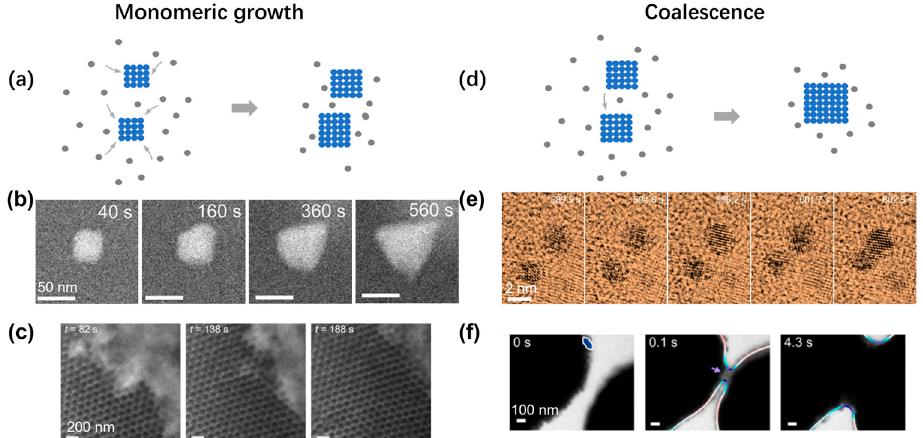
Figure 6. Experimental observations of crystal growth inside liquid-phase TEM: ( a ) Schematic illustrating the growth of crystal via monomeric attachment. ( b ) Time series of liquid-phase TEM showing the gradual growth of an individual nanoparticle. Reproduced with permission from Ref. [73]. Copyright 2021 American Chemical Society. ( c ) Time series of liquid-phase TEM showing the growth of an extended nanoparticle superlattice. Reproduced with permission from Ref. [74]. Copyright 2020 Springer Nature. ( d ) Schematic illustrating the growth of crystal via coalescence between two particles. ( e ) Time series of liquid-phase TEM showing the coalescence between two individual nanoparticles. Reproduced with permission from Ref. [75]. Copyright 2018 Springer Nature. ( f ) Time-lapse liquid-phase TEM images showing the coalescence of clusters assembled from gold nanoarrows. Reproduced with permission from Ref. [76]. Copyright 2020 American Chemical Society.